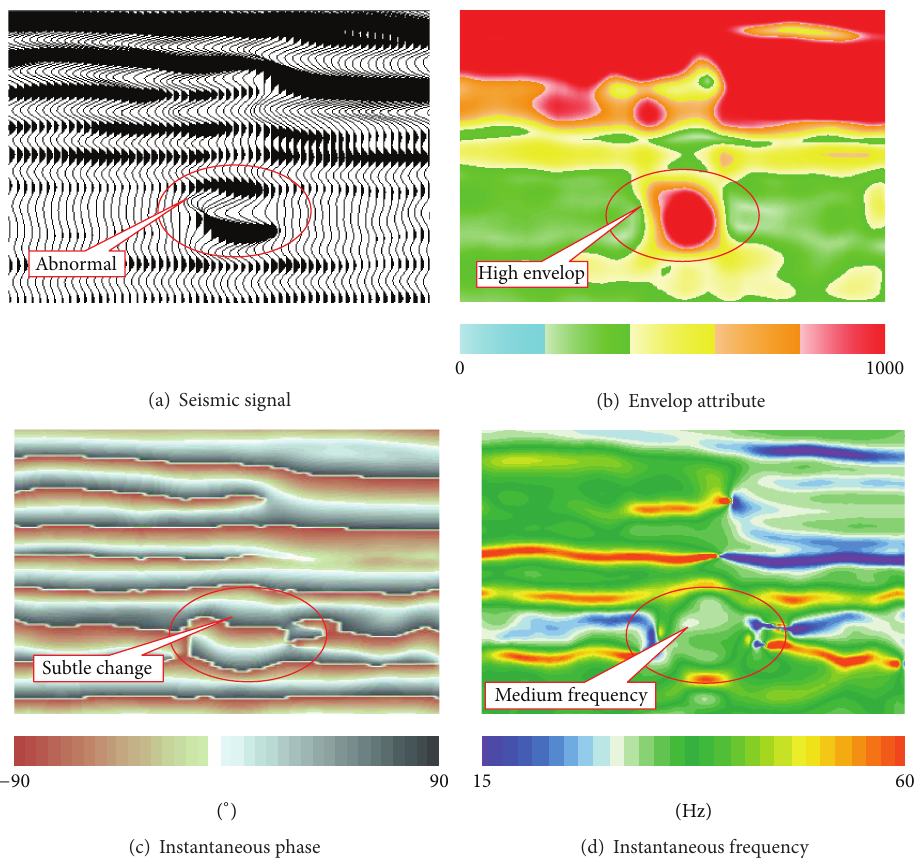
Figure 2: The original seismic signal and its derivated attributes. The abnormal seismic waves show specific characters in the three attribute profiles,